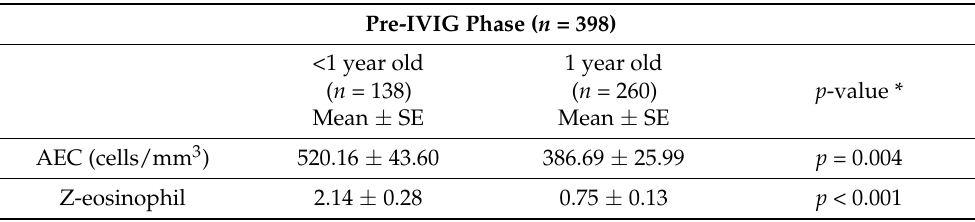
Table 2. Comparison of age subgroups with the most significant absolute eosinophil counts and Z-eosinophil difference during each Kawasaki disease